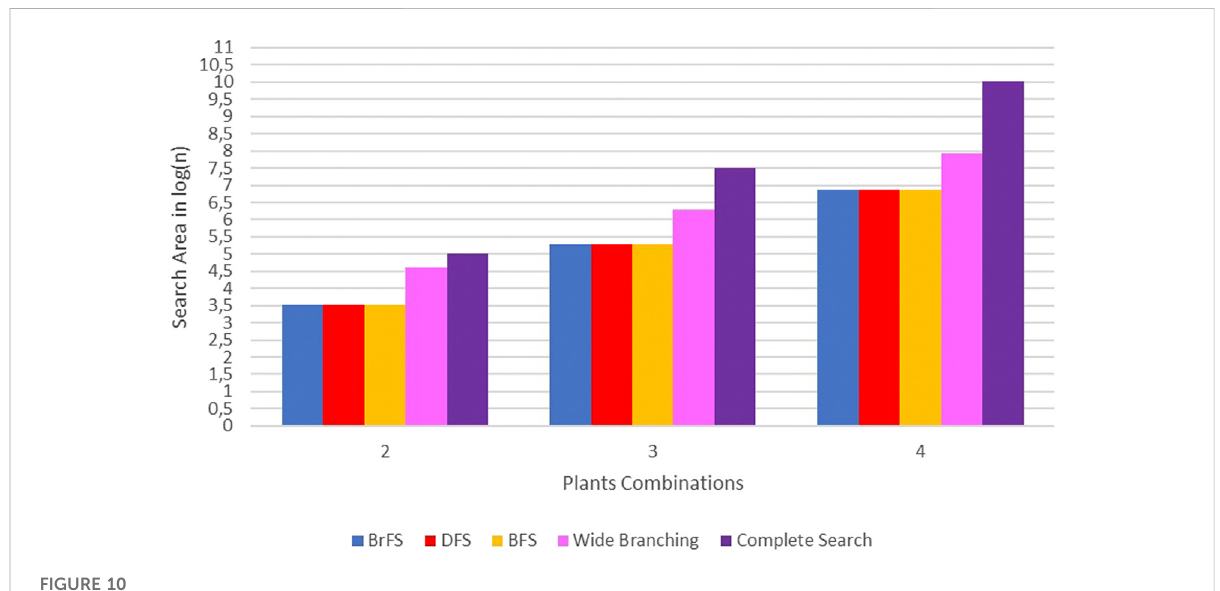
FIGURE 10 Comparison of search space area in log(n)